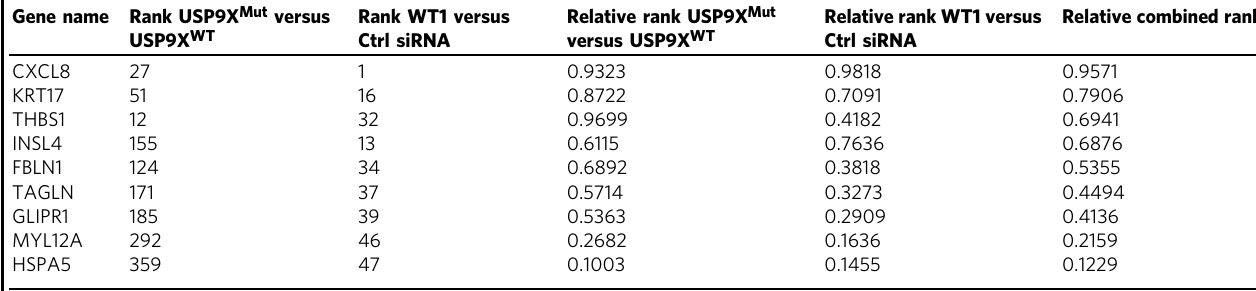
Table 1 Genes regulated by phosphorylated USP9X and WT1. Gene name Rank USP9X Mut